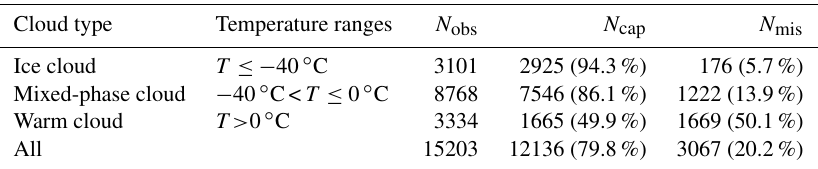
Figure 2. Spatial variabilities of RH, water vapor ( Q ), and temperature ( T ) from CAM5 simulation and HIPPO observation (left), and their differences (right). Absolute difference between CAM5 and HIPPO is shown for RH and T , while the ratio between CAM5 and HIPPO is shown for Q . Model performances are denoted by shaded vertical bars: green (red) denotes when the model captures (misses) the observed cloud occurrences, and blue denotes when the model simulates a cloud that is not present in the observation. Table 2. The numbers of cloud occurrences in the 10s averaged observations ( N obs ) , as well as those that CAM5 captures ( N cap ) or misses ( N mis ) within the model grid boxes for different temperature ranges. The ratio of N cap and N mis to N obs are given in parenthesis next to